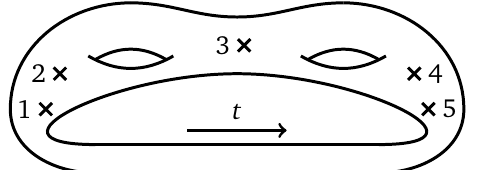
Figure 5: Worldsheet near the non-separating degeneration of a genus-three five-point